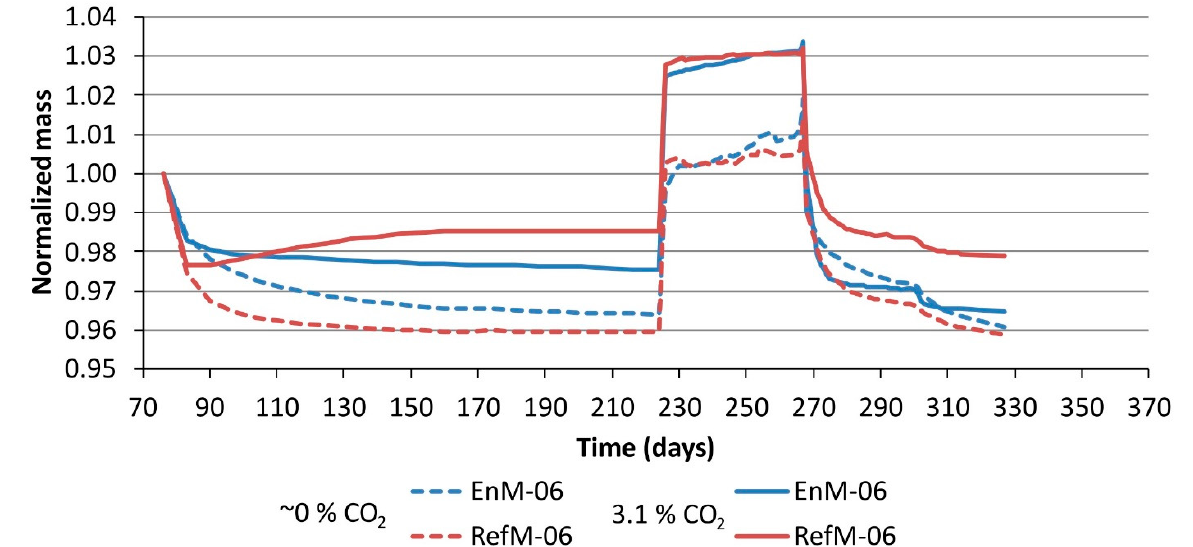
Figure 6. Mass changes during the moisture transport experiment for thin plates with a water/cement ratio of 0.6. In stage 2, group “3%” was exposed to carbonation in a 3.1% CO 2 environment and group “0%” to conditioning in a ~0% CO 2 environment. “EnM” and “RefM” stand for EnDurCrete and reference mortar respectively.